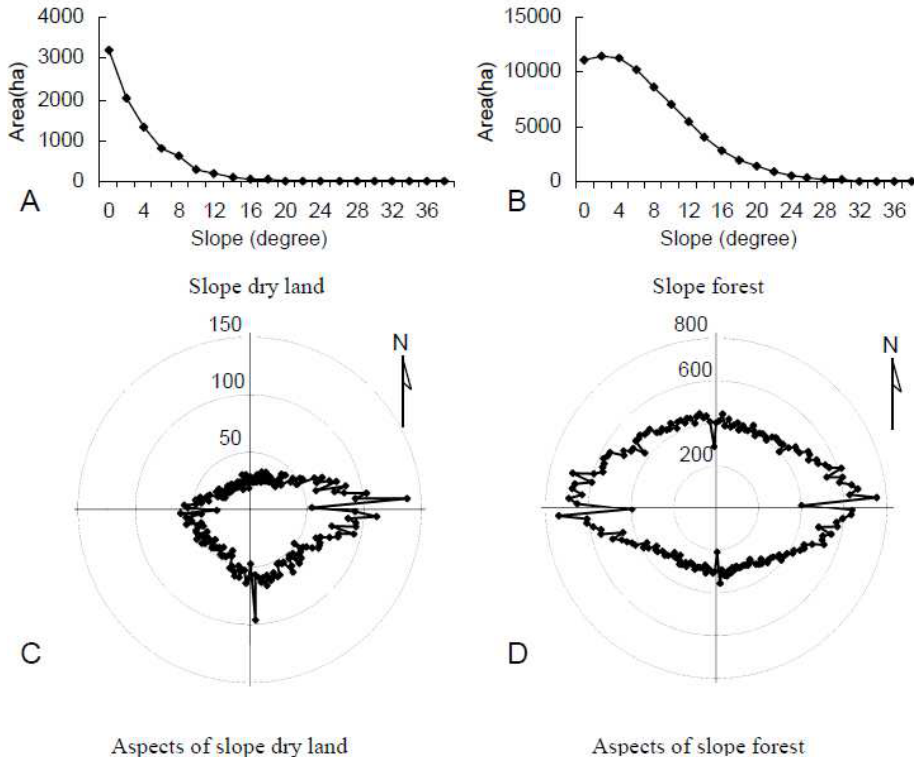
Figure 4. Dry land and forest on sloped land over 4 degrees in 1989.